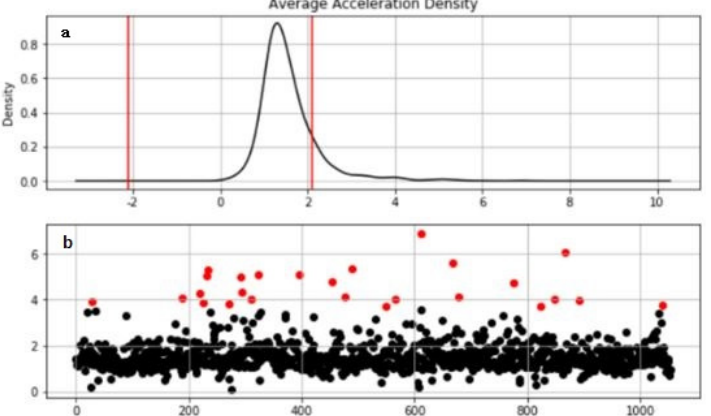
Figure 8. Abnormal point correction: ( a ) Acceleration distribution map; ( b ) Abnormal point.